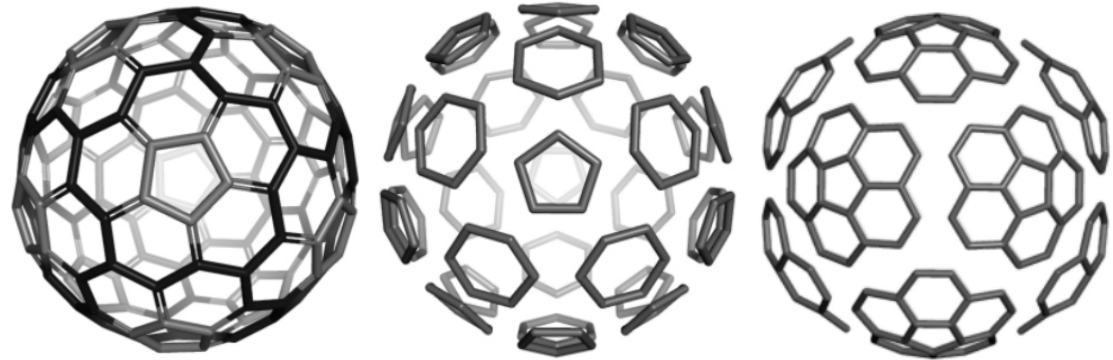
Figure 1. Patches in fullerenes: [5:6